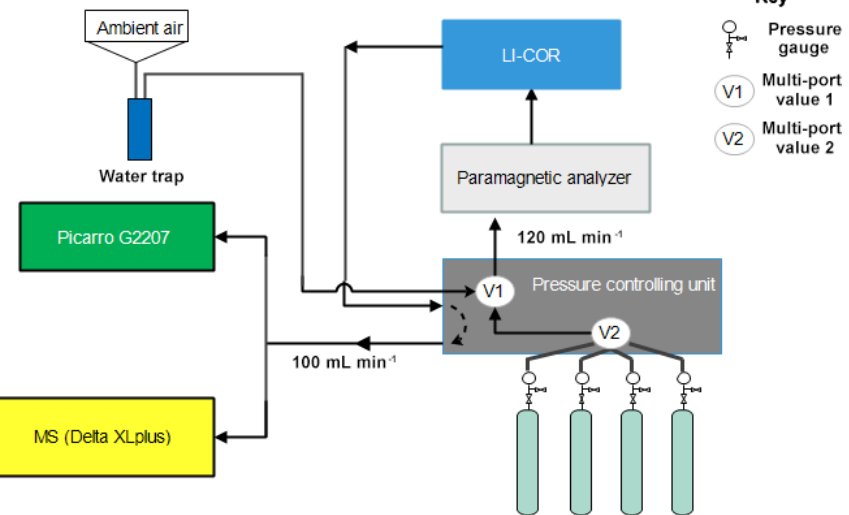
Figure 11. Schematics of the measurement system used to compare the Picarro analyzer with the mass spectrometer at